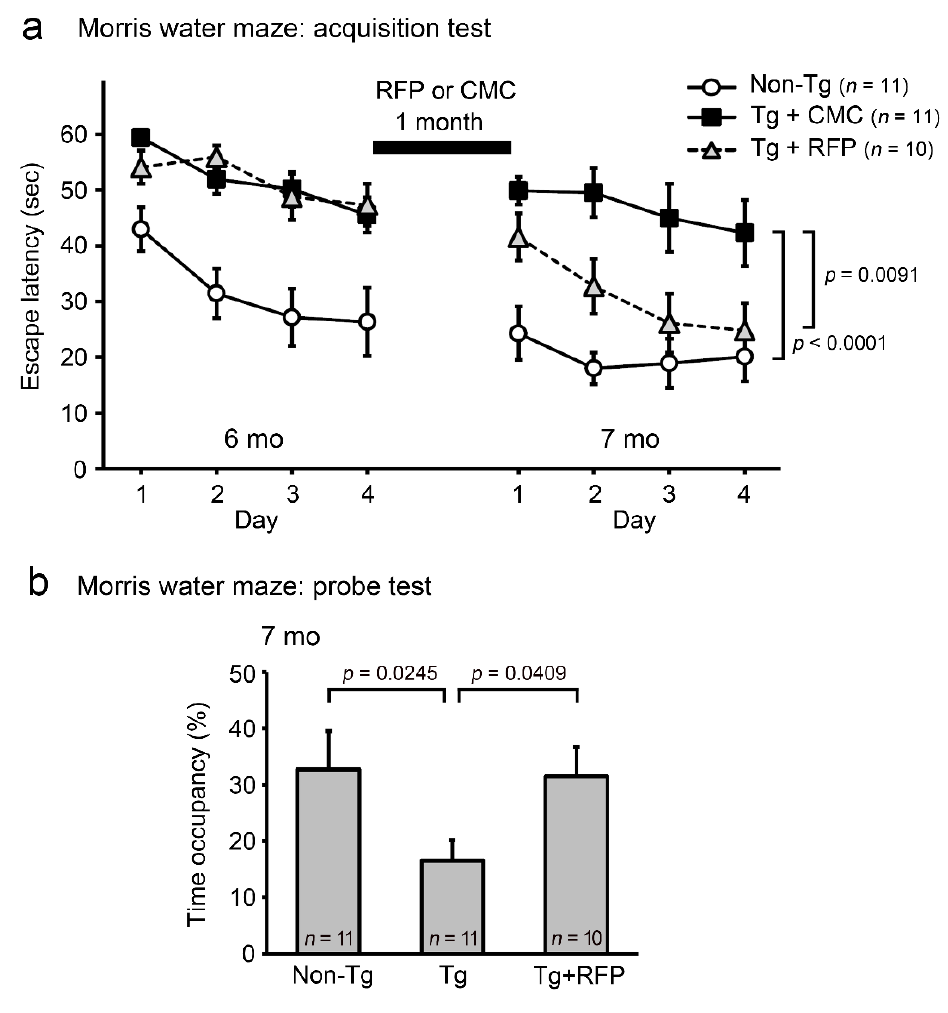
Figure 4. Effect of intranasal rifampicin on the cognition of Tg mice. After the Morris water maze test in Figure 1c–d, 6-month-old (mo) Tg mice were divided into 2 groups. One group was intranasally treated with rifampicin (RFP) at 0.1 mg/day for 1 month and the other was treated with CMC. Non-Tg littermates were treated with CMC only. After treatment, a second water maze test was performed. The numbers of mice assigned are shown in each figure. ( a ) Rifampicin significantly improved the memory of Tg mice. The curves on the left prior to rifampicin treatment (6 months) are reproduced from the data shown in Figure 1c. ( b ) Memory retention was also ameliorated by rifampicin treatment.